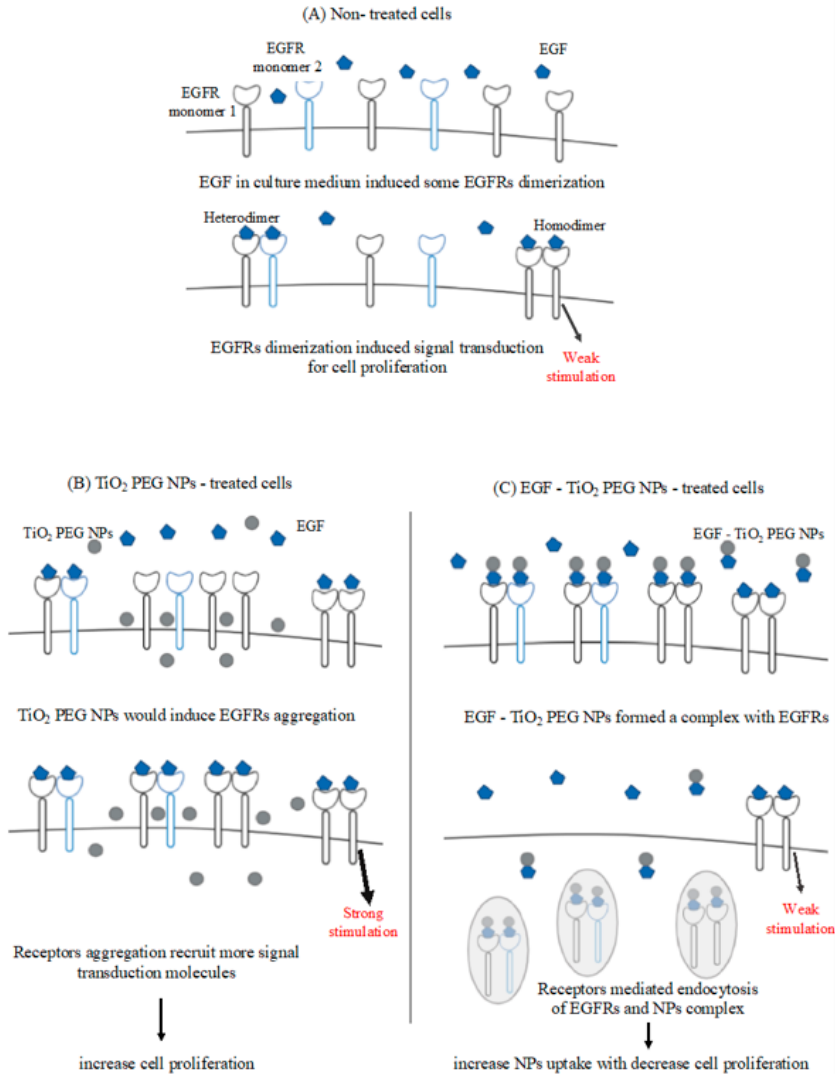
Figure 6. Proposed putative molecular mechanism for the e ff ect of EGF conjugation on TiO 2 PEG NPs uptake levels and the cell proliferation e ff ect via interaction with EGFRs. ( A ) Represents non-treated A431 cells, ( B ) represents TiO 2 PEG NPs-treated A431 cells, ( C ) represents EGF-TiO 2 PEG NPs-treated